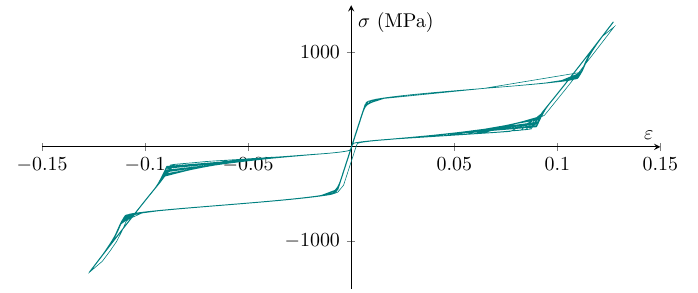
Figure 5. The stress–strain curves of the Abaqus SMA material model proposed by Auricchio [44–46] and the properties provided by Pereiro-Barceló and Bonet [43].